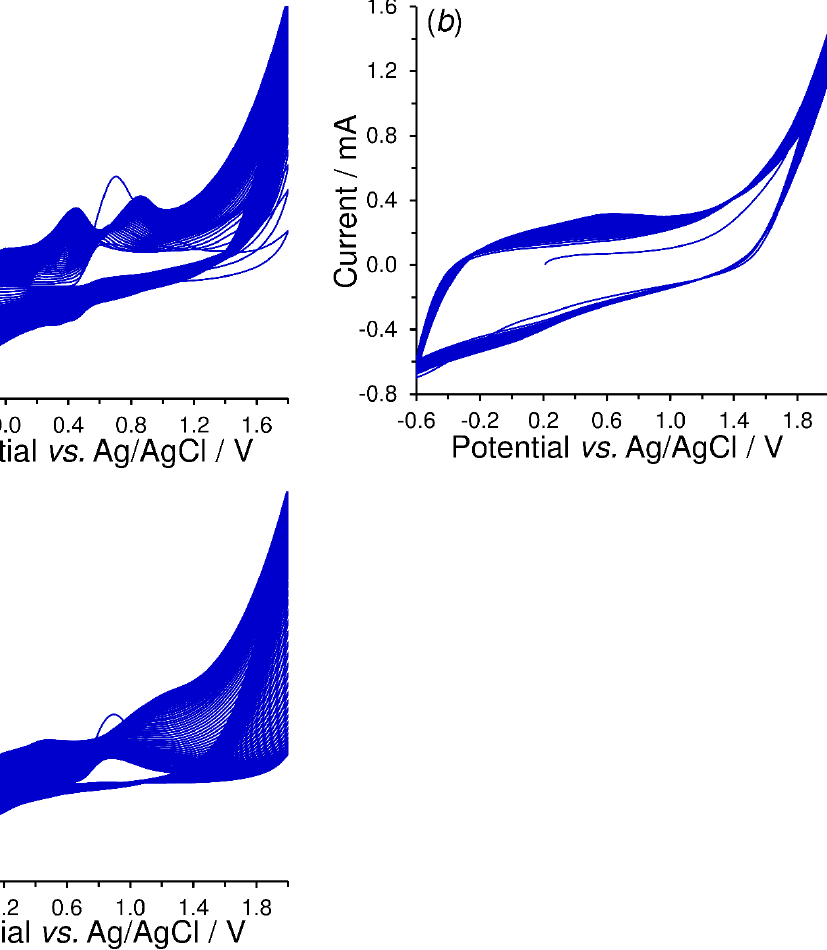
Figure 1. A set of voltammograms obtained by repetitive potential cycling (RPC, n = 50) of 2 mg mL −1 vanillin in 0.1 mol L −1 PB of pH 7 ( a ), 2 mg mL −1 cinnamaldehyde dissolved in mixture of 0.5 mol L −1 H 2 SO 4 and 96% ethanol (3:7) ( b ), and 2 mg mL −1 4-hydroxybenzaldehyde in 0.1 mol L −1 PB of pH 7 ( c ) recorded on SPCE at E step = 5 mV and ν = 200 mV s −1 .